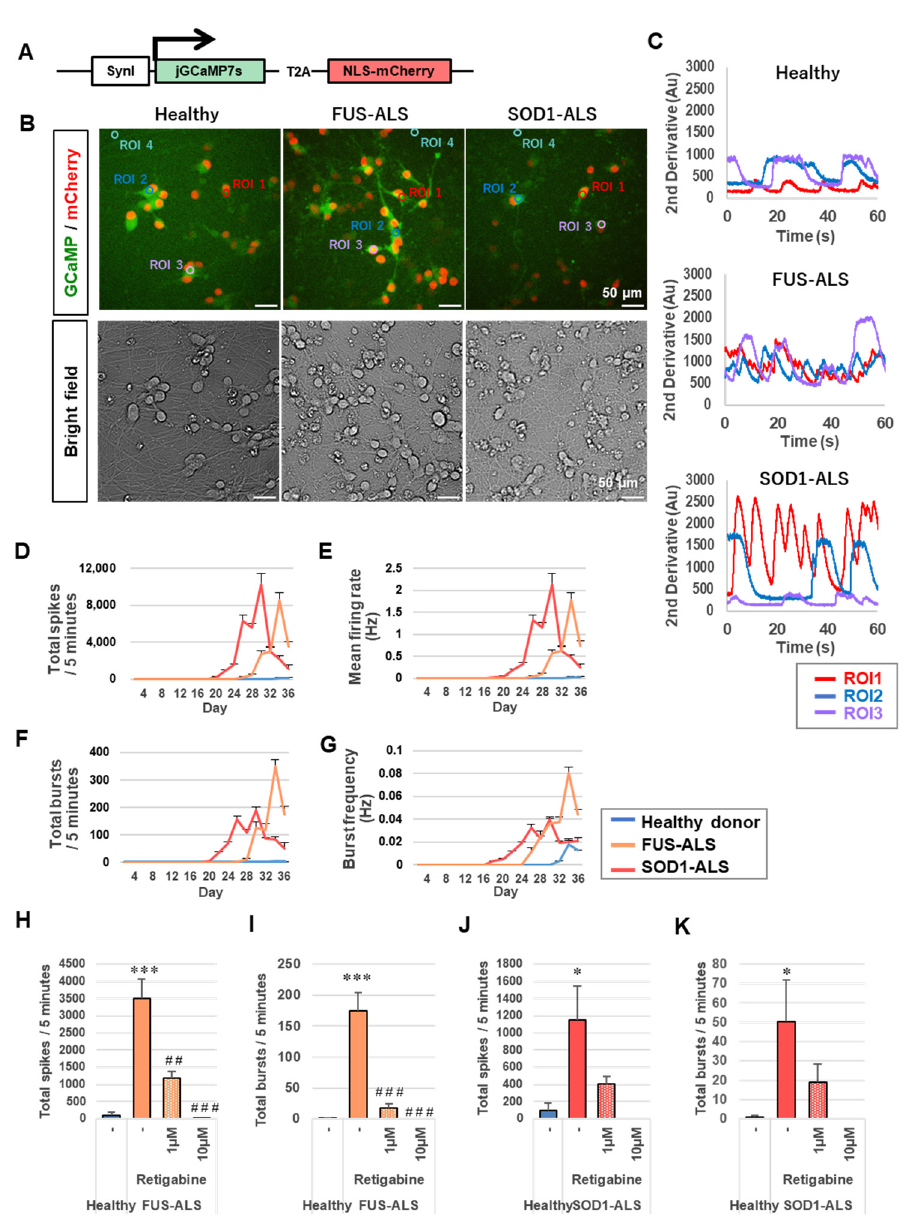
Figure 4. Evaluation of neuronal activity and hyperexcitation in ALS using iPSC-derived motor neurons. ( A ) Vector design for neuronal expression of GCaMP and mCherry in the nucleus. ( B ) Representative GCaMP, mCherry, and brightfield images of the induced motor neuron on day 14. ROIs (ROI1-3) are depicted in ( C ) as time-dependent changes in GFP fluorescence intensity. Scale bar: 50 µ m. From days 4–36: ( D ) the number of spikes; ( E ) mean firing rate; ( F ) the number of bursts; and ( G ) burst frequency was evaluated. Each value represents mean ± SEM (Healthy: n = 11, FUS -ALS: n = 11, SOD1 -ALS: n = 10, mean ± SEM). The effect of retigabine on the increase in ( H ) the number of spikes; ( I ) bursts in FUS -ALS and the number of ( J ) spikes; and ( K ) bursts in SOD1 -ALS were evaluated on day 36 (healthy: n = 5, FUS-DMSO: n = 4, FUS-1 µmol L − 1 retigabine: n = 3, FUS-10 µmol L − 1 retigabine: n = 4, SOD1-DMSO: n = 4, SOD1-1 µmol L − 1 retigabine: n = 3, SOD1-10 µmol L − 1 retigabine: n = 3, mean ± SEM). *: p < 0.05 vs. healthy control ( t -test), ***: p < 0.001 vs. healthy control (t-test); ##: p < 0.01 vs. vehicle control (Dunne tt test), ###: p < 0.001 vs. vehicle control (Dunne tt test).